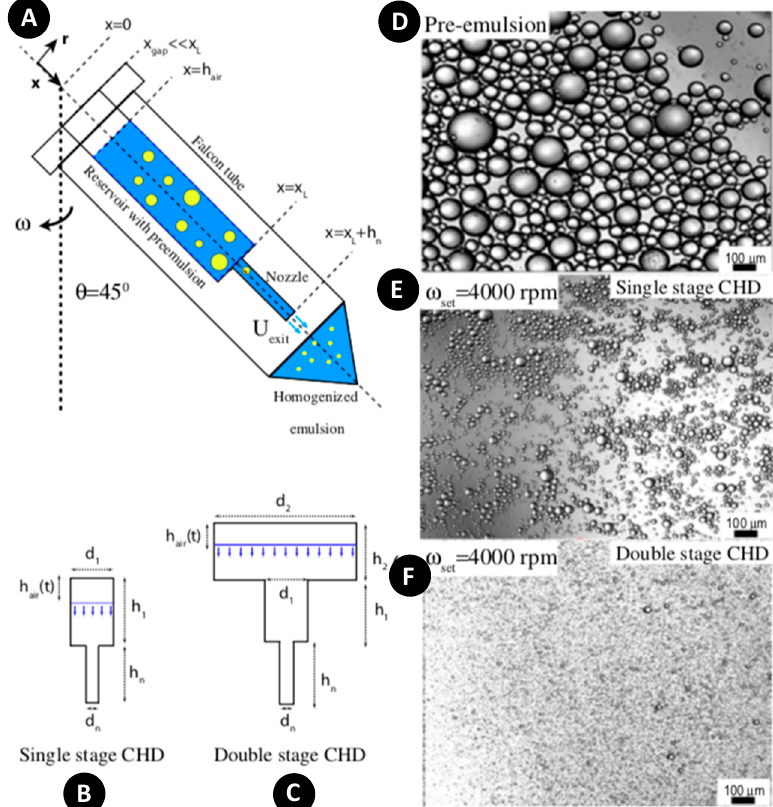
Figure 18. ( A ) Schematic of centrifugal homogenization device (CHD) in which a 20 mL syringe used as a reservoir and a nozzle dispenses the emulsions into the falcon tube cap. The whole system rotates at an angle of 45 ◦ to the rotation axis; ( B ) Schematic of the single-stage CHD with 2 mL reservoir; ( C ) Schematic of the double-stage reservoir with two reservoirs, i.e., a 2 mL and another 20 mL; ( D – F ) Microscope images of coarse pre-emulsion and resulting emulsions after homogenization at 4000 RPM and repeating the process 5 times. Reprinted with permission from [129].